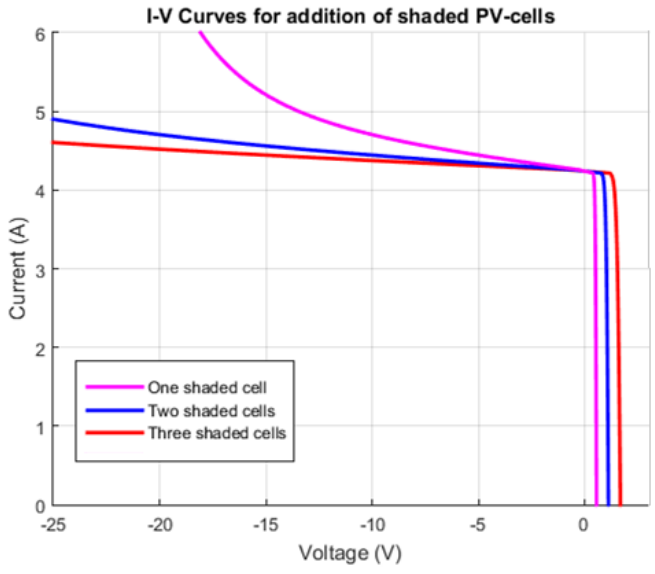
Figure 7. Simulation of I–V Curves for addition of shaded PV-cells.